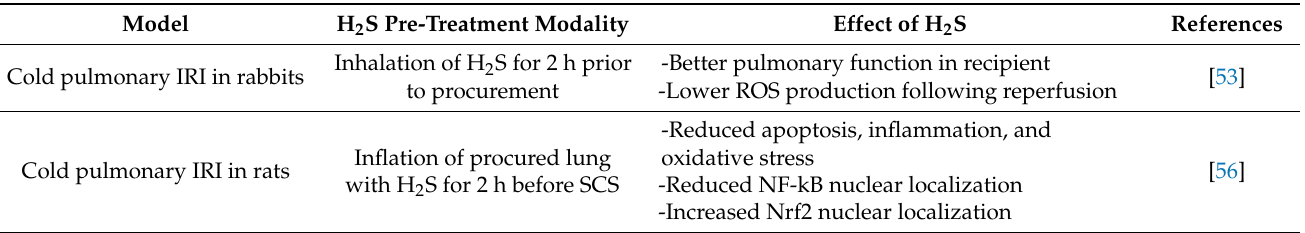
Table 2. Summary of protective effects of exogenous H 2 S pre-treatment in animal models of cold and warm